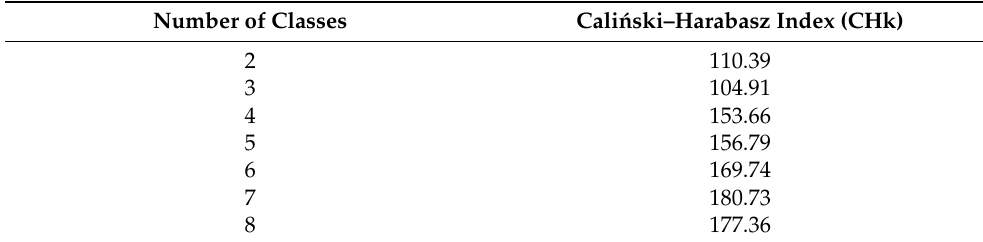
Table 3. The selection of the optimal number of classes to group 50 spring wheat genotypes with the Ward method.